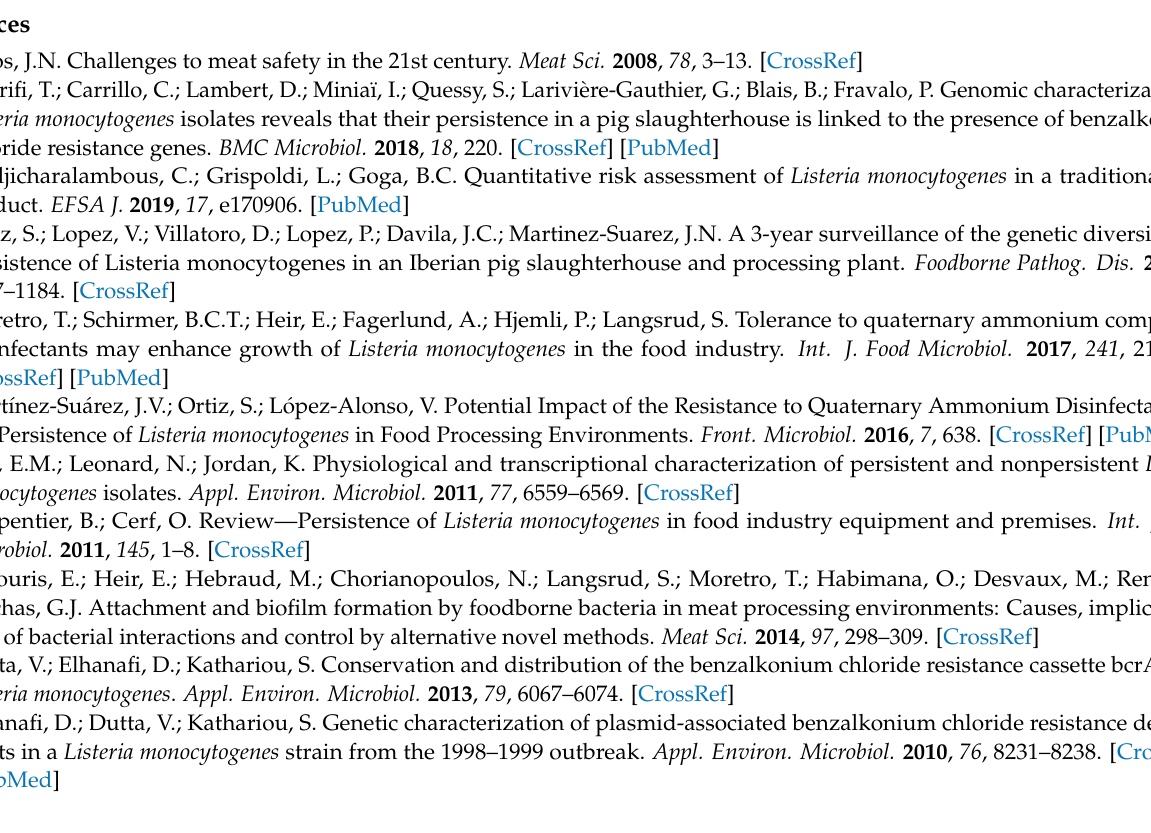
Supplementary Figure S1: Rarefaction curve of OTUs for each sample collected from meat conveyor surfaces. Supplementary Figure S2: Relative frequency of bacterial species identified from OTUs detected in cutting facility conveyor surfaces according to positive samples in Listeria monocytogenes culture-based